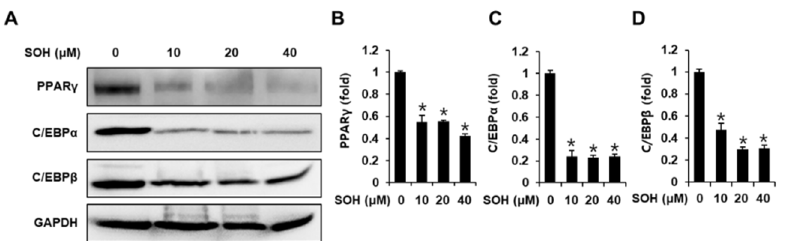
Figure 3. Inhibitory effects of SOH on the expression of adipogenesis-related proteins in differentiated 3T3L-1 cells. ( A ) Protein expression of peroxisome proliferator-activated receptor gamma (PPAR γ ), CCAAT/enhancer-binding protein alpha (C/EBP α ), CCAAT/enhancer-binding protein beta (C/EBP β ), and glyceraldehyde 3-phosphate dehydrogenase (GAPDH) in differentiated 3T3L-1 cells on day 8 after treatment with SOH. ( B – D ) Analysis of the ratios of band intensities of PPAR γ , C/EBP α , and C/EBP β in treated cells compared with those of untreated differentiated 3T3L-1 cells (three independent replicates, * p < 0.05, Kruskal-Wallis nonparametric test). Data are shown as means ± SEM.